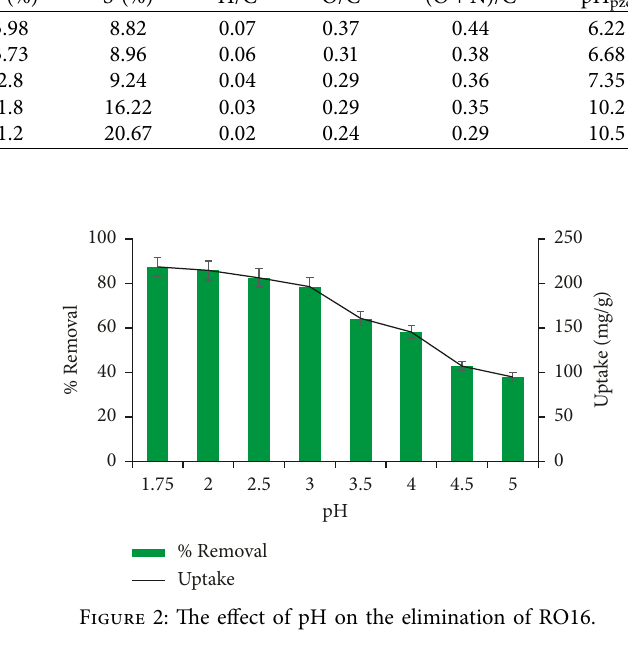
Figure 2: The effect of pH on the elimination of RO16.